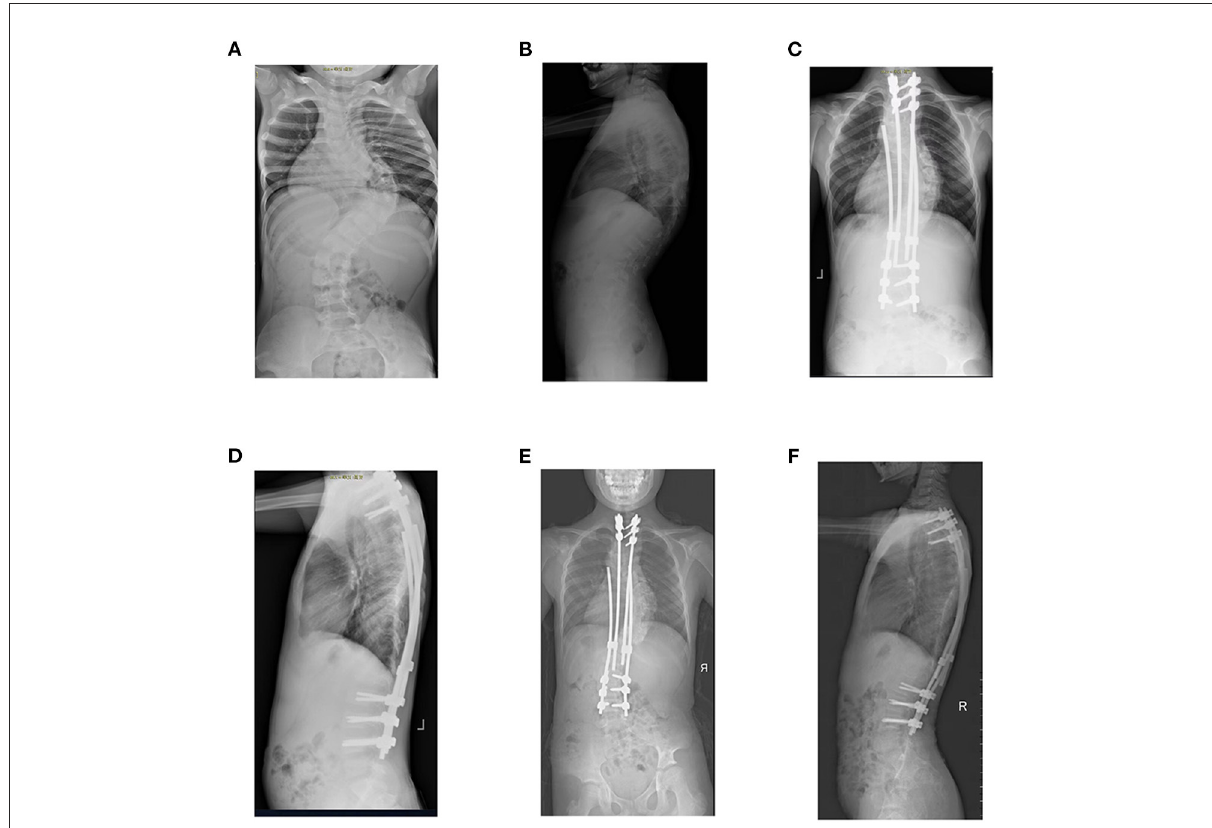
FIGURE1 Boy aged 7 years and 8 months diagnosed with kyphotic early-onset scoliosis. (A,B) preoperative anteroposterior and lateral radiographs of the spine indicate coronal lateral bending of 91 ◦ and sagittal thoracic kyphosis of 63 ◦ . (C,D) X-ray re-examination shows satisfactory correction of kyphosis after growing-rod implantation. (E,F) X-ray re-examination at the 38th month of follow-up (the 4th strutting surgery) showed a satisfactory correction effect and an increase in spinal